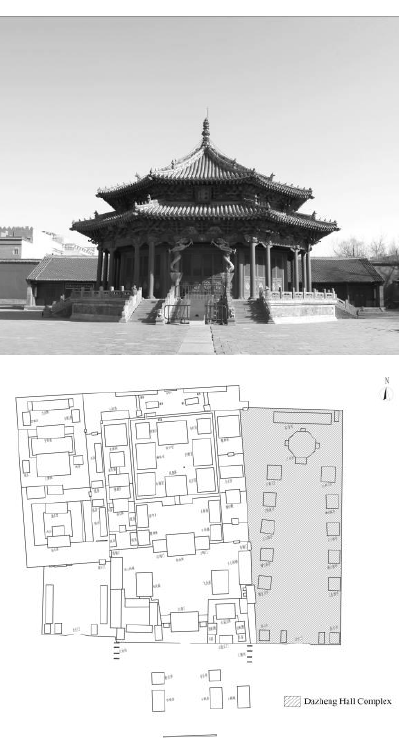
Figure. 2. Site of Dazheng Hall Complex in Mukden Palace